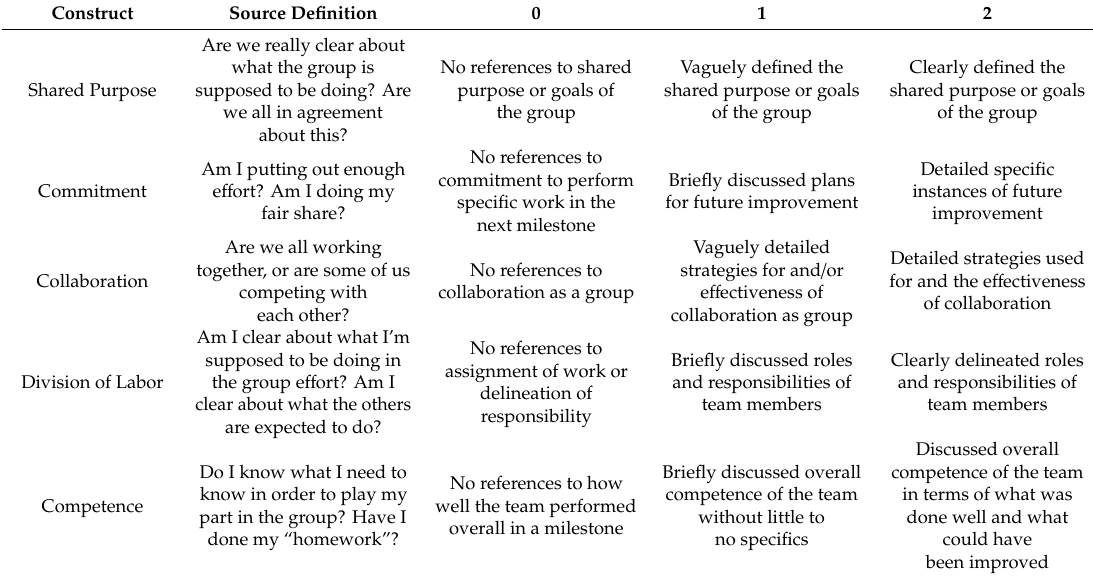
Table 3. Leadership rubric representing the constructs, definitions, and scores for each